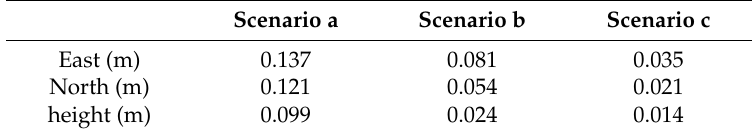
Table 2. RMSe of the differences between the photogrammetric solutions and the GPS positions.